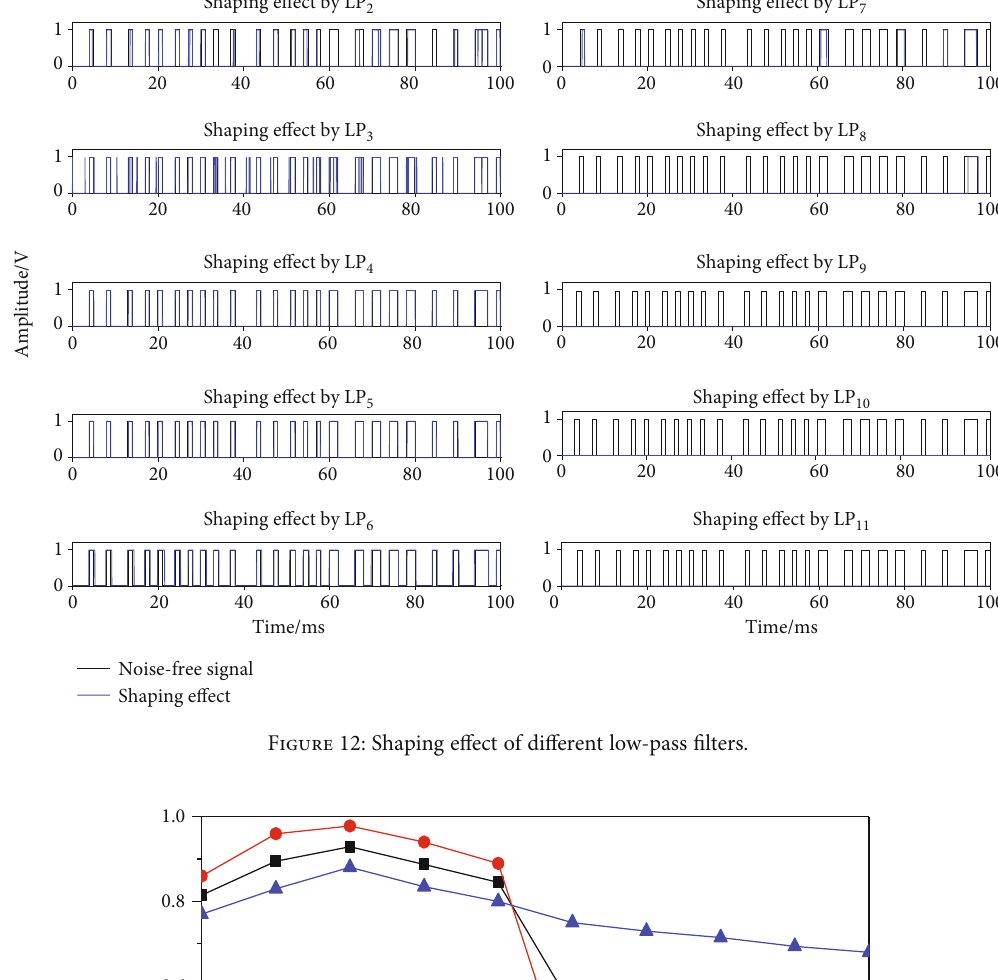
Figure 12: Shaping e ff ect of di ff erent low-pass fi lters.